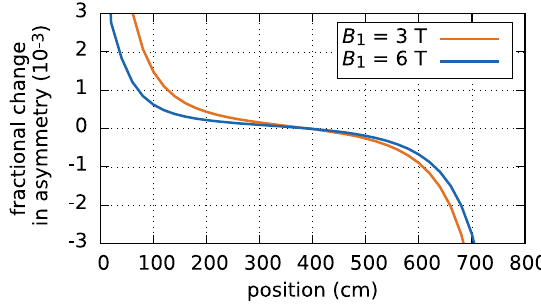
Figure 5. Fractional change of the measured asymmetry calculated for a point source located on the central axis at position z . The reference point is the centre of the long solenoid at z = 4 m. (Field calculation without return yoke).